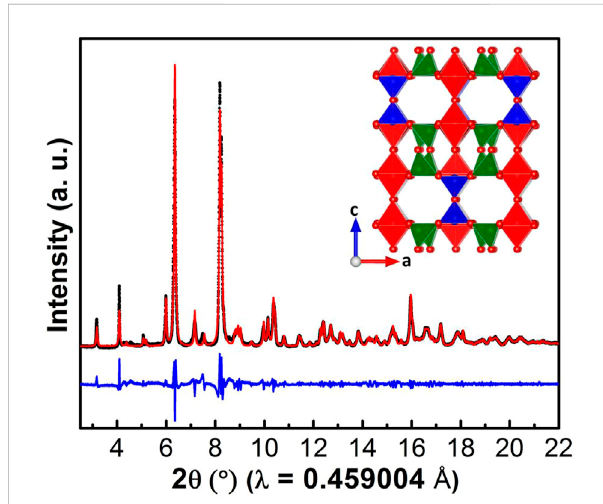
Synchrotron XRD pattern collected on V 4 O 9 sample prepared at 300 ° C. The red dots and black and blue solid lines correspond to observed and calculated patterns and their difference, respectively. (Crystal structure of V 4 O 9 is shown in inset).